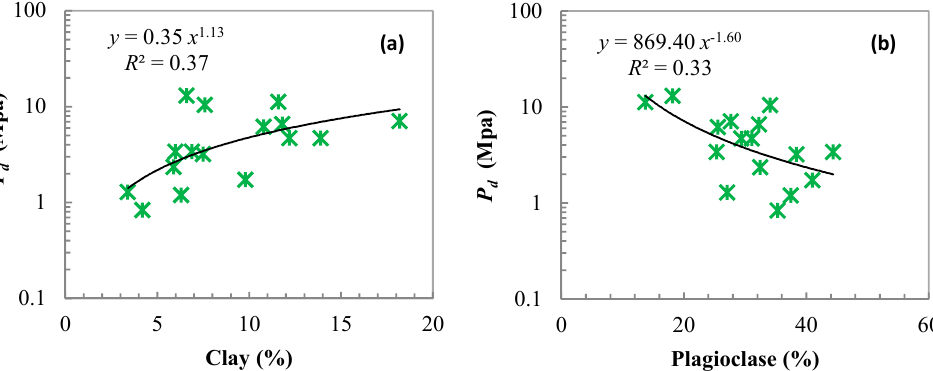
Figure 6. The cross plot of displacement pressure with clay and plagioclase contents.